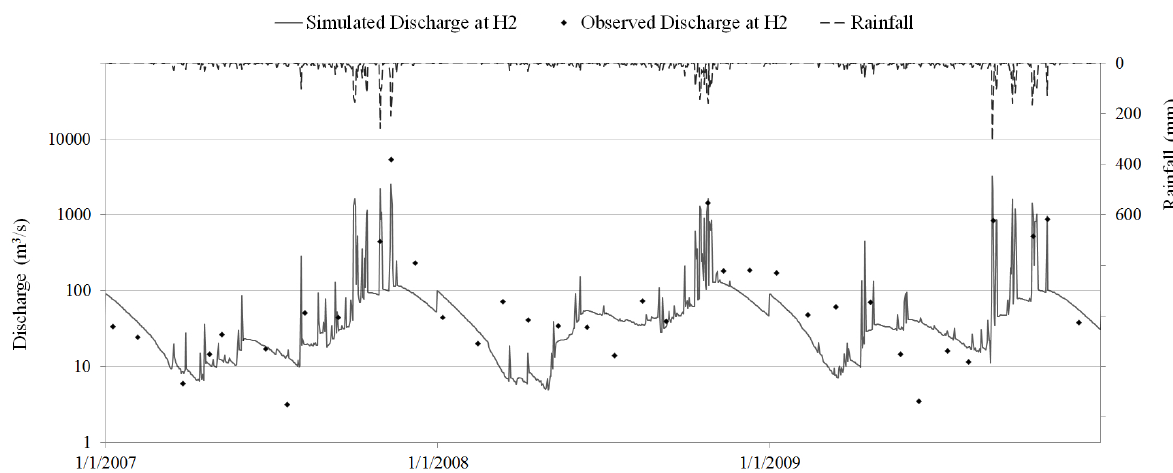
Figure 7. River discharge validation at H2.